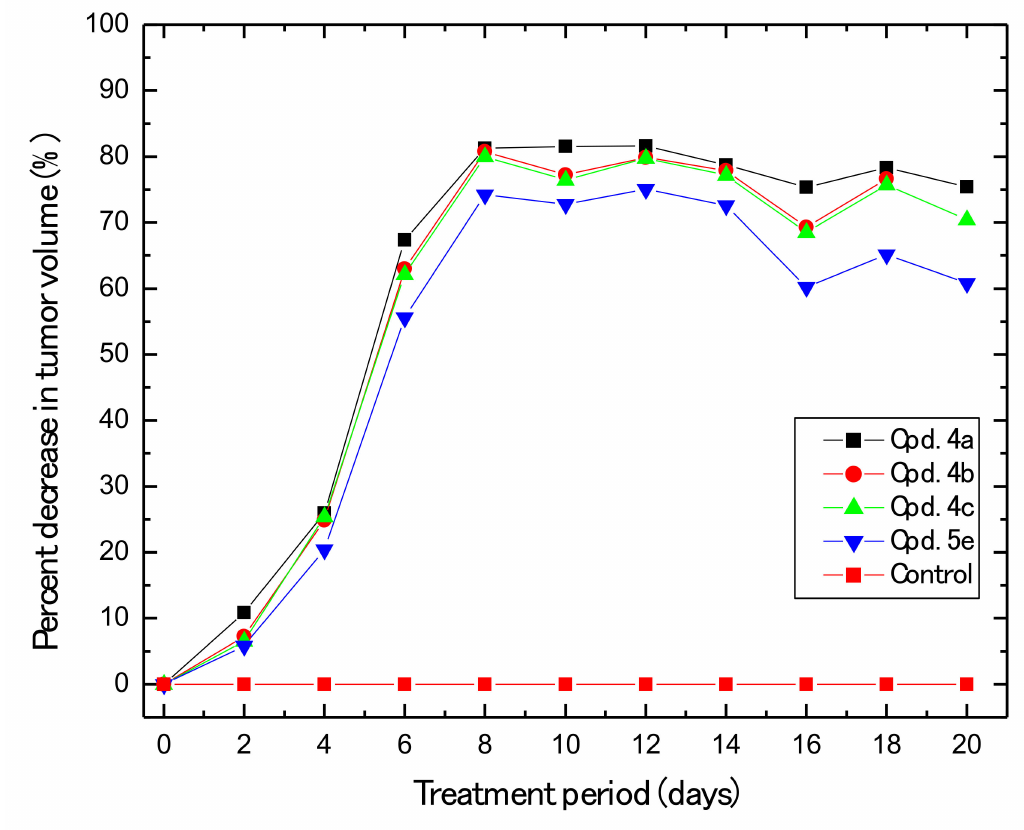
Figure 3. Decreased percentage ofin vivotumor growth in response to di ff erent compound